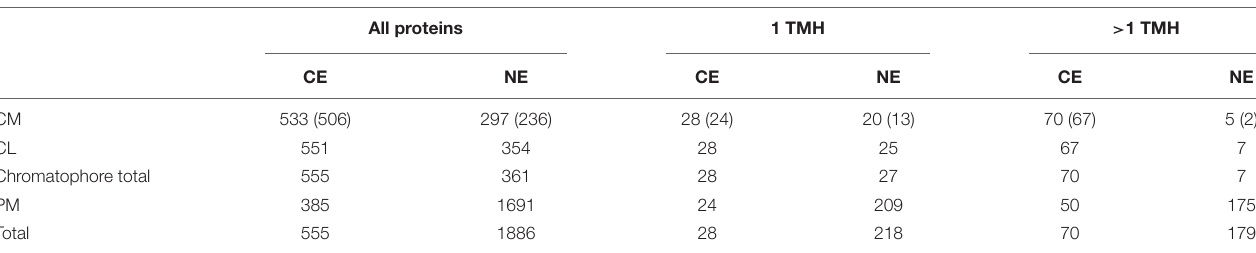
FIGURE 2 | Increased recovery of TM proteins by MS analysis of enriched insoluble chromatophore proteins. (A) TEM micrographs of isolated chromatophore (left) and chromatophore in the context of a P. chromatophora cell (right). The outer envelope membrane (OM) observed in intact cells was lost during the isolation process. IM, inner envelope membrane; PG, peptidoglycan; TM, thylakoid membranes; Cb, carboxysomes. (B) 1 µ g of protein from three replicates of each, chromatophore lysates (CL) as well as high salt and carbonate-washed P. chromatophora (PM) and chromatophore membranes (CM) was resolved on a 4–20% polyacrylamide gel and silver stained. (C) Numbers of proteins encoded on the chromatophore genome (Genome) and chromatophore-encoded proteins identified with ≥ 3 SpC in chromatophore-derived samples in our previous (2017) and current (This study) proteome analysis. The number of predicted TMHs is indicated by a color code. (D) Detection of chromatophore-encoded transport systems. Annotation or TCDB-family, predicted mode of transport, substrates, and probable subcellular localization are provided. For each protein, the mean normalized intensity in CM (over both MS experiments) is indicated by a color code (see also Supplementary Table S2 ). TABLE 2 | Proteins identified in this study by